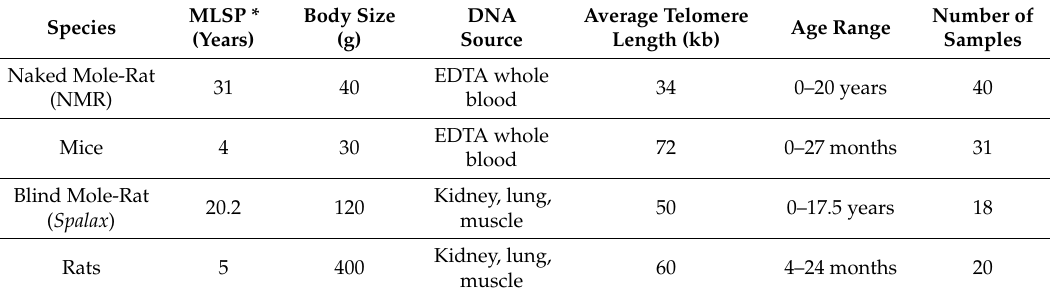
Table 1. List of species included in the study.